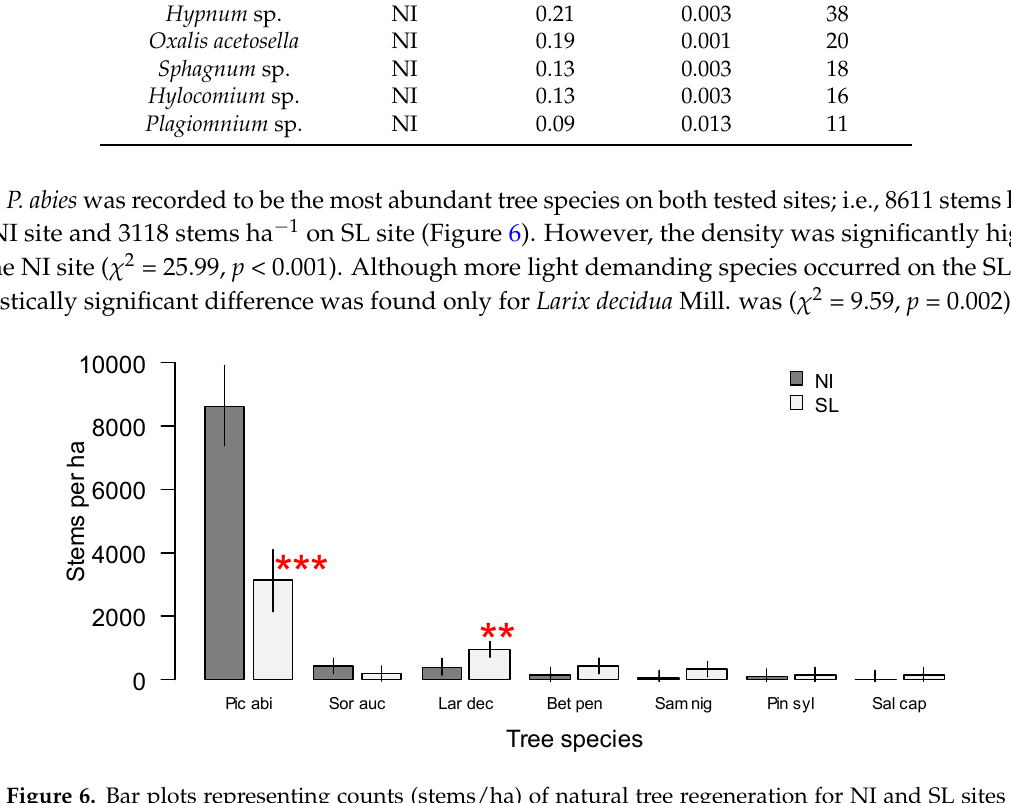
Figure 6. Bar plots representing counts (stems/ha) of natural tree regeneration for NI and SL sites (statistical significance: “***” < 0.001, “**” < 0.01, “ ” not significant). Acronyms used: “Bet pen” Betula pendula , “Lar dec” Larix decidua , “Pic abi” Picea abies , “Pin syl” Pinus sylvestris, “Sal cap” Salix caprea (L.), “Sam nig” Sambucus nigra (L.), and “Sor auc” Sorbus aucuparia